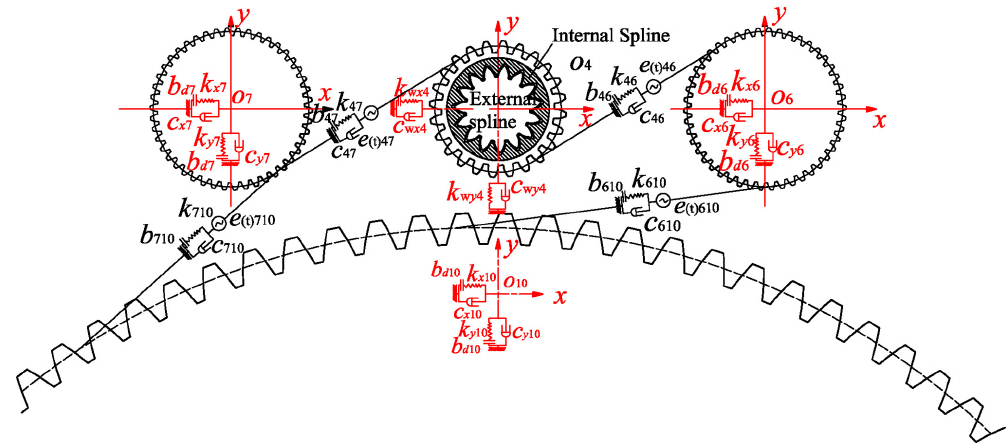
Figure 5. Dynamics model of the two-stage pinion O 4 under the supporting action of spline shaft.